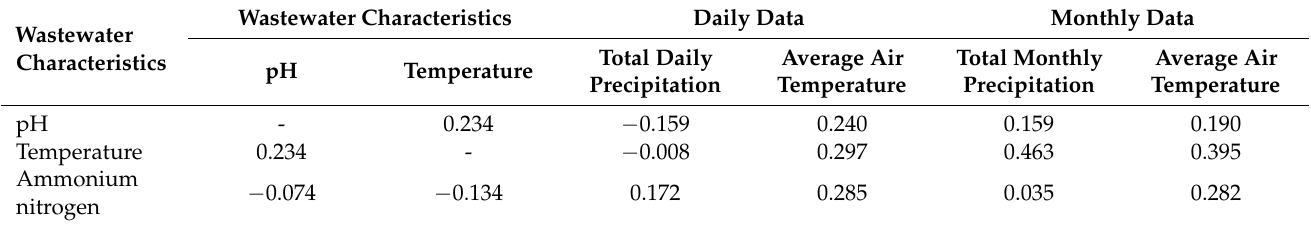
Table 4. The results of the r-Pearson analysis of the correlation between the change in the param- eters of industrial wastewater generated during the municipal waste bio-drying process and the weather data at the municipal waste disposal plant (ZUOK) in Olsztyn between December 2015 and December